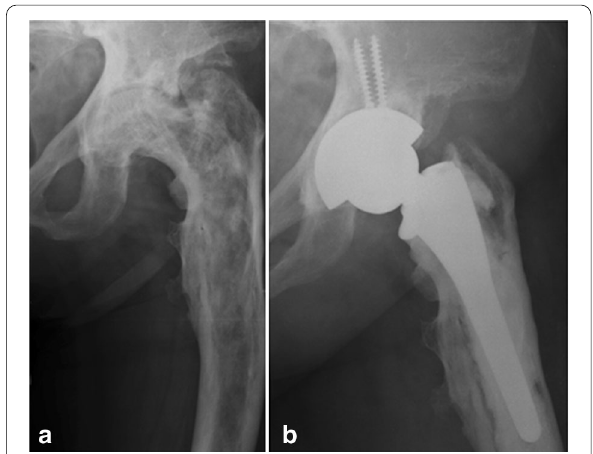
Fig. 3 a Pre-operative anteroposterior X-ray of the hip of a woman who was 60 years old at the time of surgery; b 1-year post-operative X-ray showing wide radiolucent lines along the cement–bone interface at the